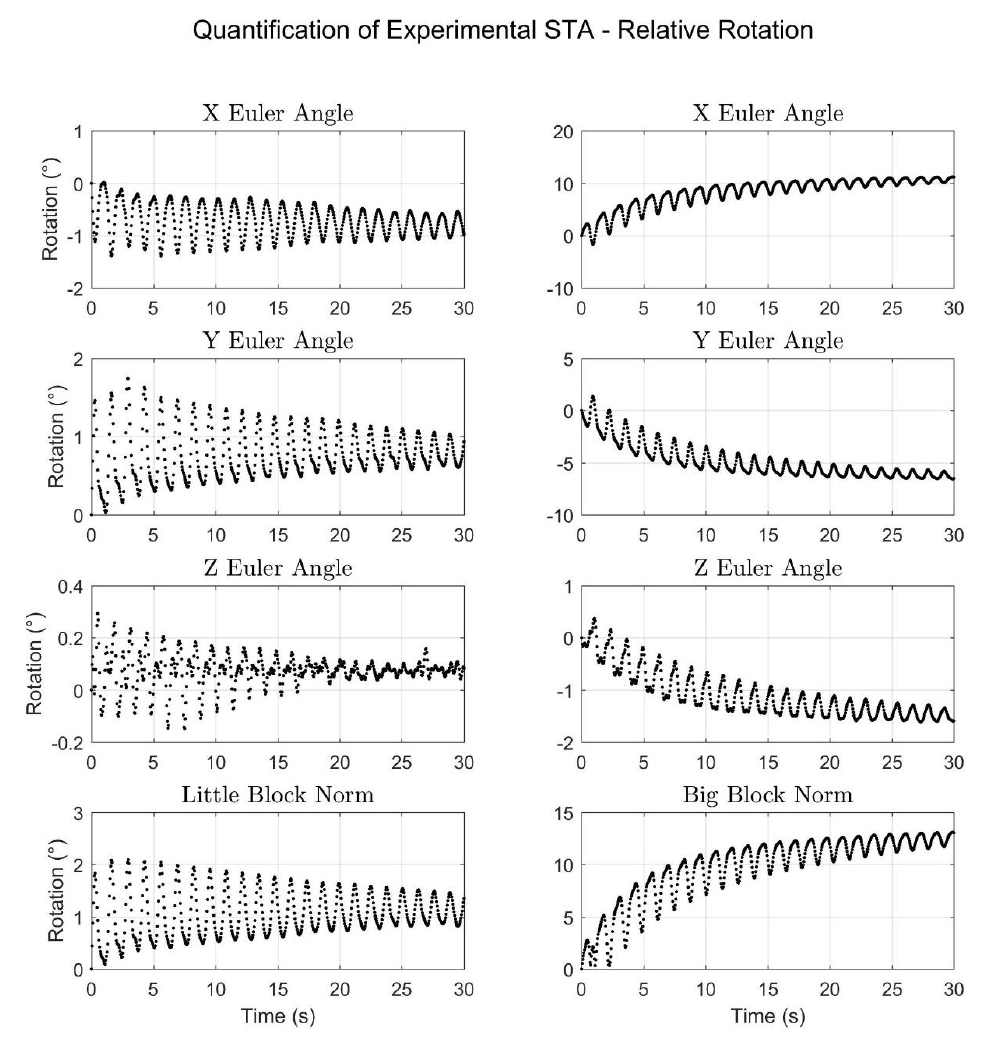
Figure 11. The rotational motion of the meat sensor relative to the rigid sensor shown as Euler angles ( XYZ ) and their corresponding norm for both the little block trial ( left ) and the big block trial ( right ). The results are expressed in the 𝑋 ̂ 𝑌 ̂ 𝑍 ̂ coordinate system. Table 3. Values describing both the overall and oscillatory range of motion (ROM) due to the simulated STA in terms of relative translation and relative rotation for both the little and big block trials.